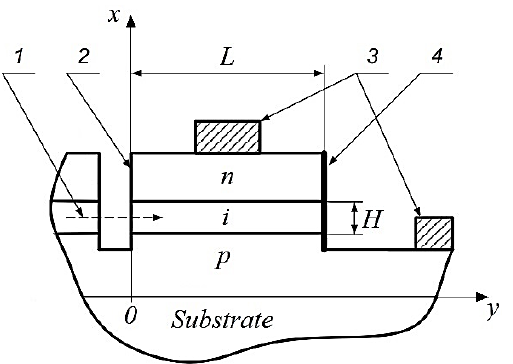
Figure 1. The cross-section of a resonant-cavity-enhanced p-i-n photodetector: 1, photon flux; 2, half-reflecting mirror; 3, ohmic contacts; 4, totally-reflecting mirror; L is the length of the resonant cavity; H is the height of the absorption region. 190